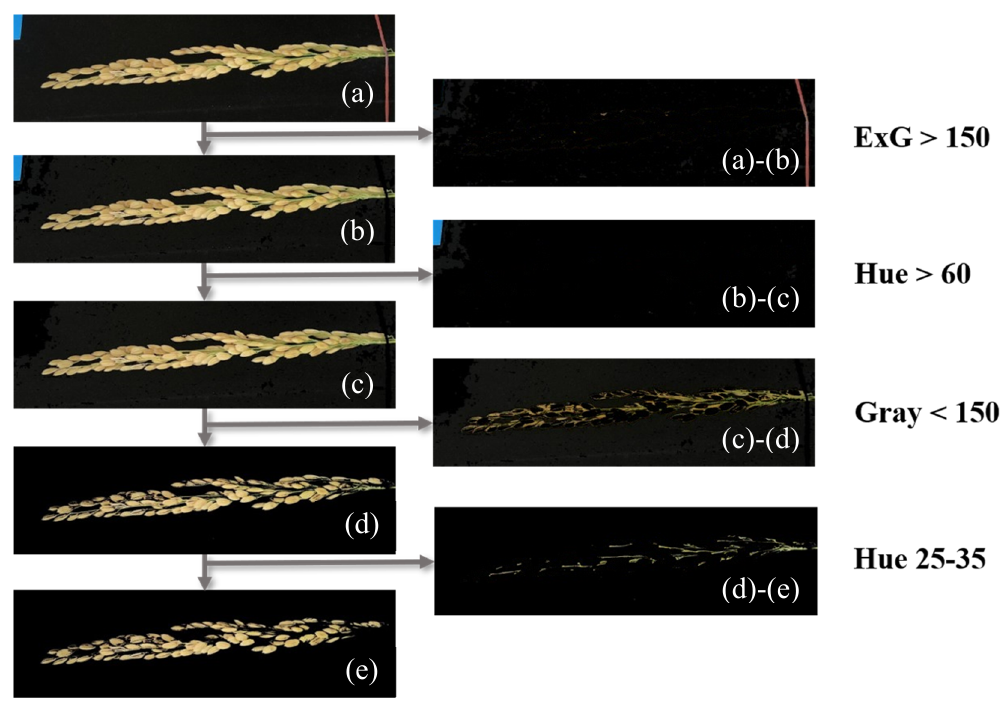
Figure 9. Background removal process included the ( a ) ROI image, ( b ) ROI image with ribbon removal, ( c ) sample card removal from image ( b ), ( d ) shadow removal from image ( c ), and ( e ) stem removal from image ( d ).